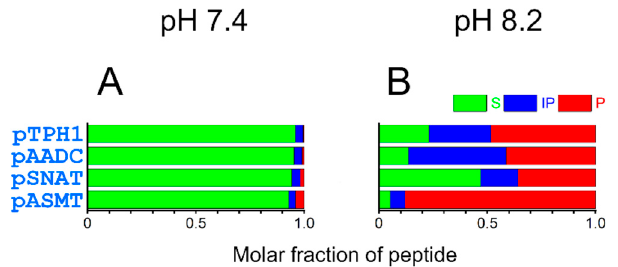
Figure 7. Molar fractions of peptides after 24 h of Ni(II)-assisted peptide bond hydrolysis at 37 °C. The results are shown for the reaction at pH 7.4 ( A ) and 8.2 ( B ). Represented are fractions of substrates (S, intact peptides, green), intermediate products (IP, ester after the acyl shift, blue), and products (P, cleaved peptides, red).